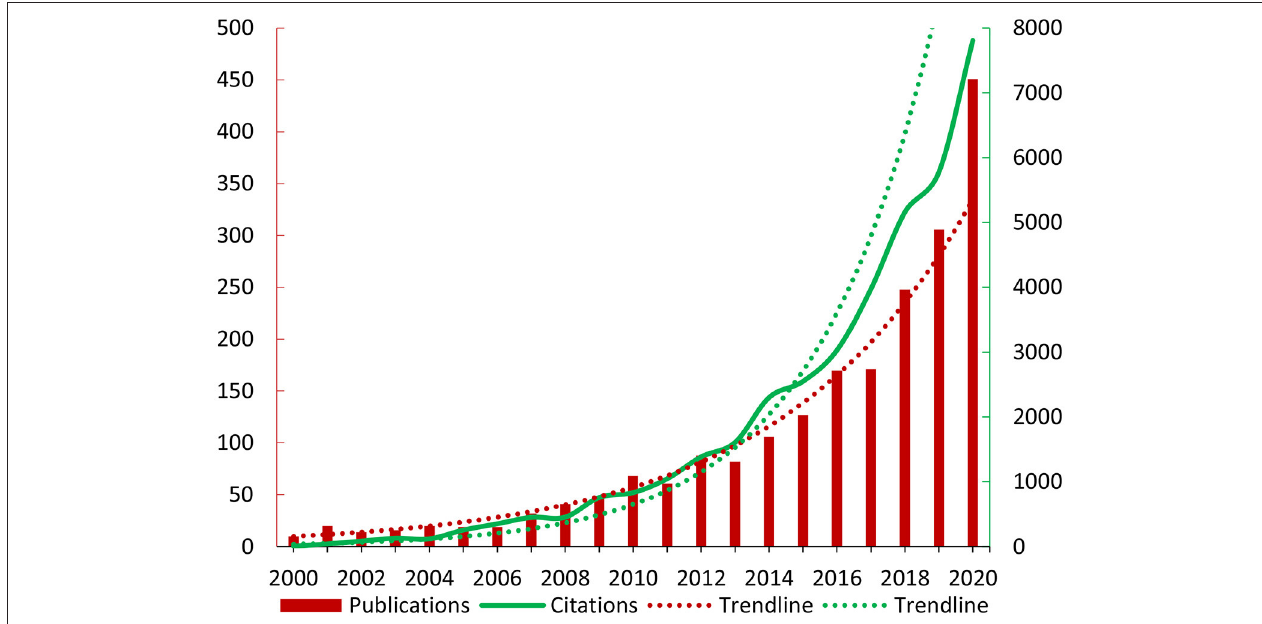
FIGURE 2 | The trend in publications and citations.